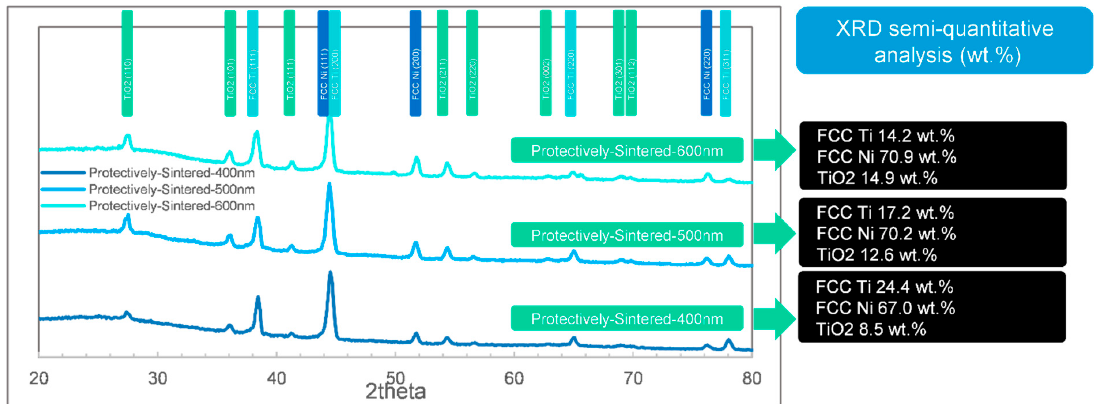
Figure 8. The XRD phase identifications (semi-quantitative analysis) by FWHM of the protective-sintered samples ranging from 400 to 600 nm.